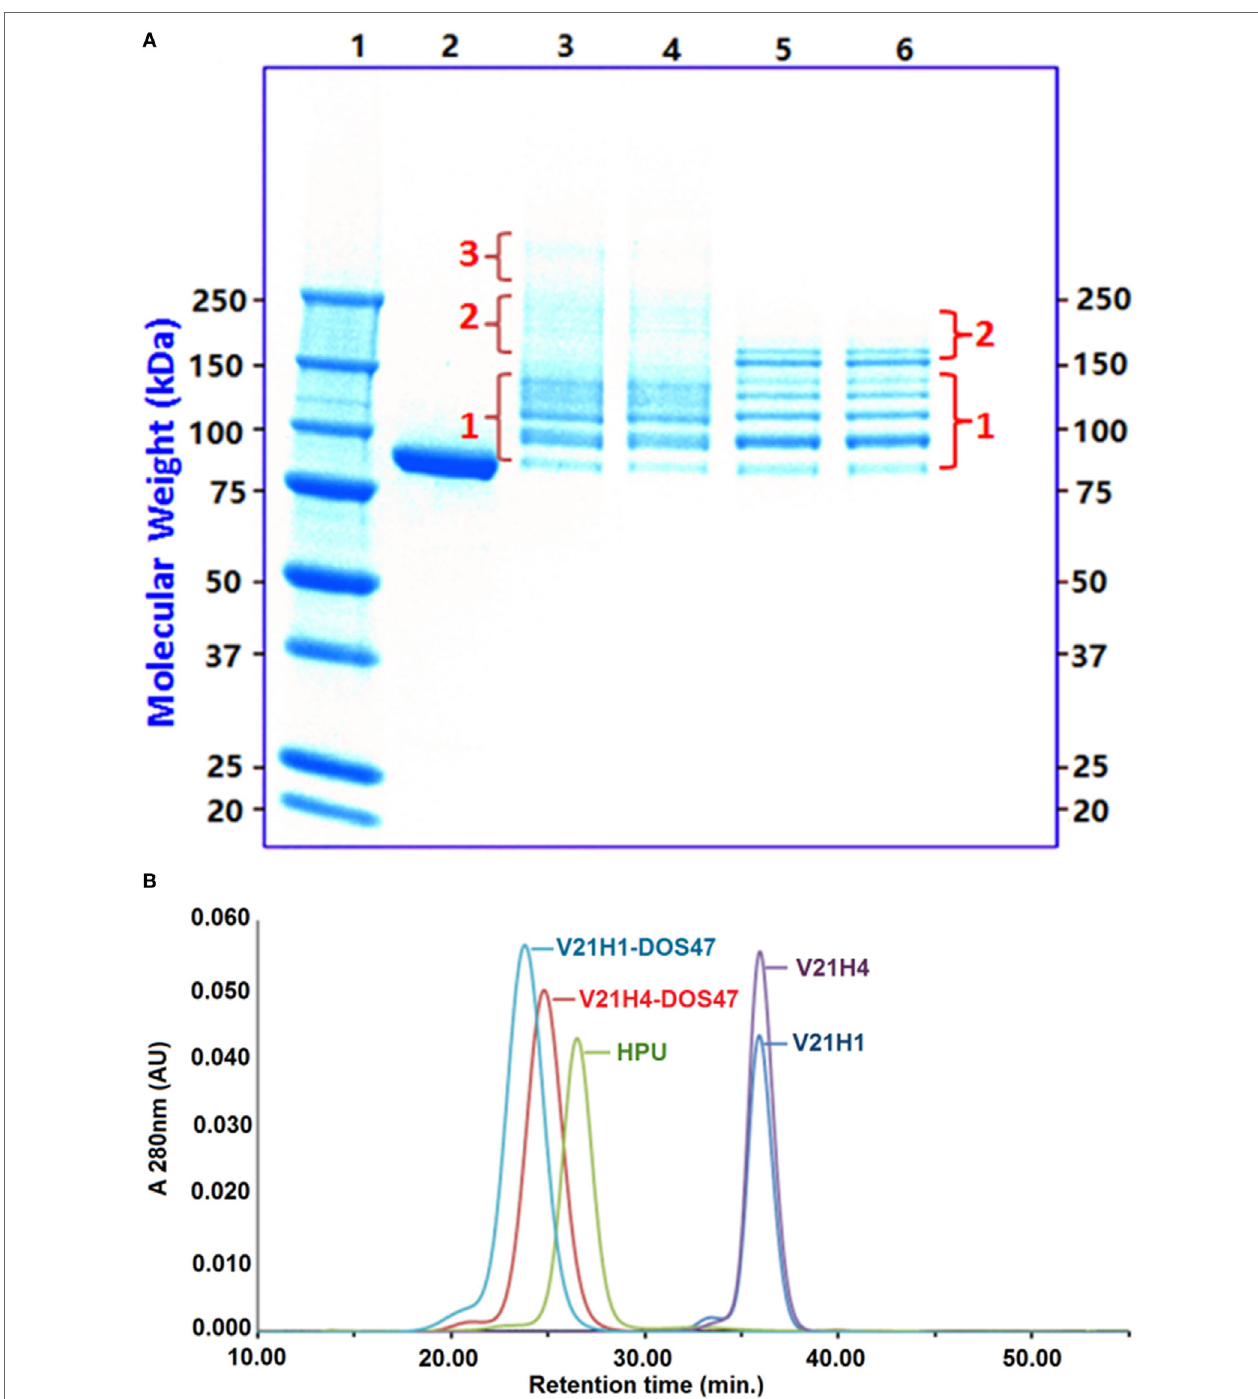
FigUre 5 | (a) SDS-PAGE of V21H1-DOS47 and V21H4-DOS47. Bands labeled in red with 1, 2, or 3 are cluster numbers. Lane 1: molecular weight ladder. Lane 2: high purity urease (HPU). Lanes 3 and 4: V21H1-DOS47. Lanes 5 and 6: V21H4-DOS47. (B) Size exclusion chromatograms of V21H1, V21H4, HPU, V21H1- DOS47, and